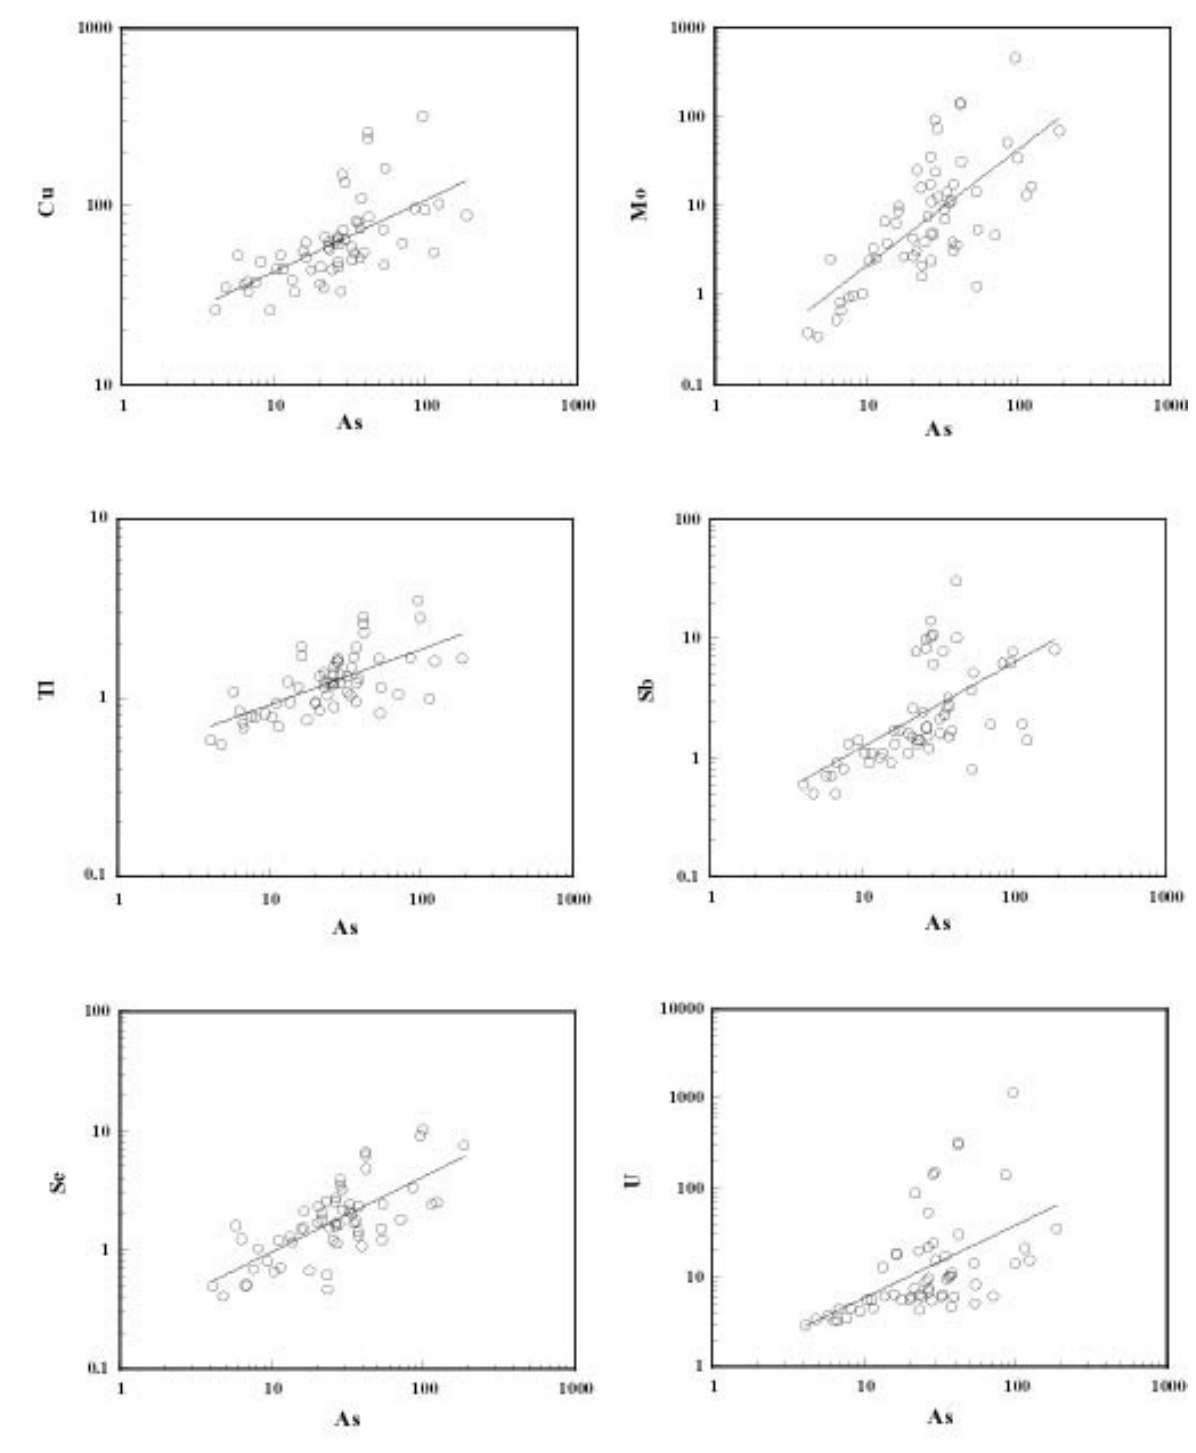
FIGURE 3 . The As vs. Cu, Mo, U, Se, Sb, and Tl correlations of soils from the study